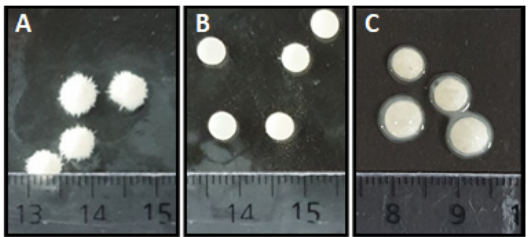
Figure 3. A. oryzae immobilized in 3% alginate after 48 h ( A ), 6% alginate after 48 h ( B ), and 6% alginate after 240 h ( C ) of incubation in main culture medium containing acetate.